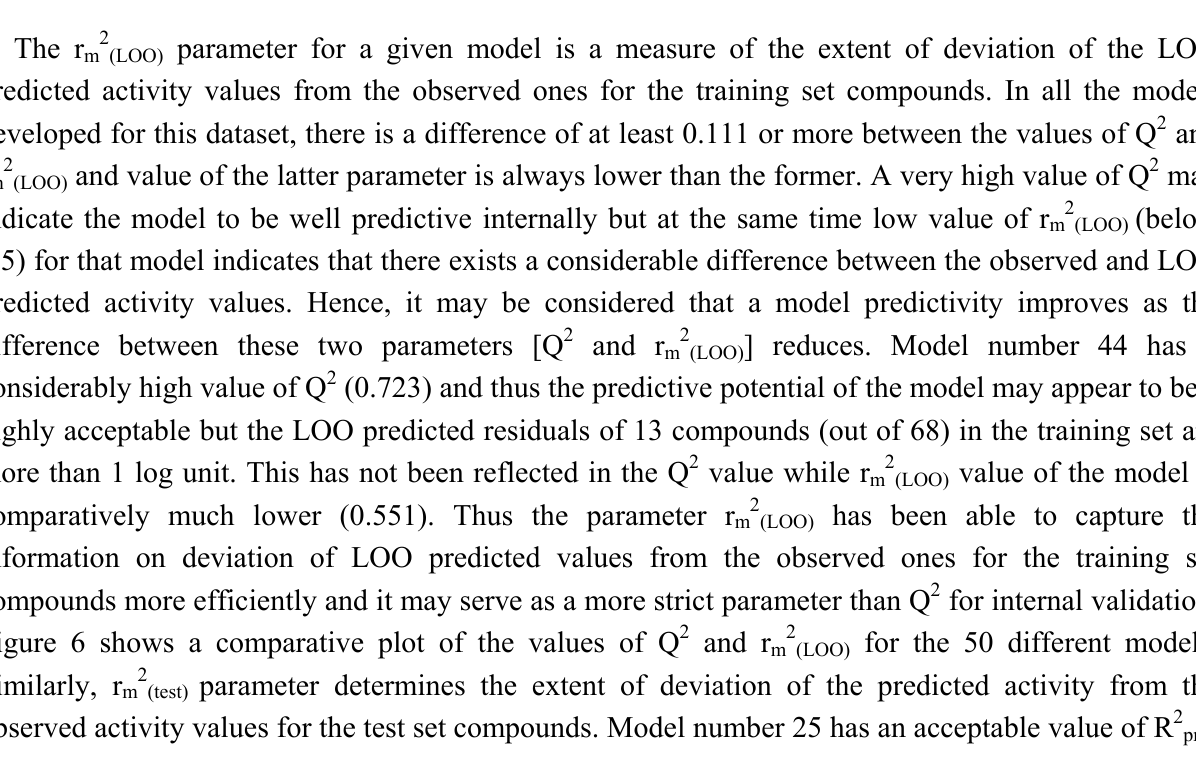
Figure 5. Comparative plots of Q 2 , R 2